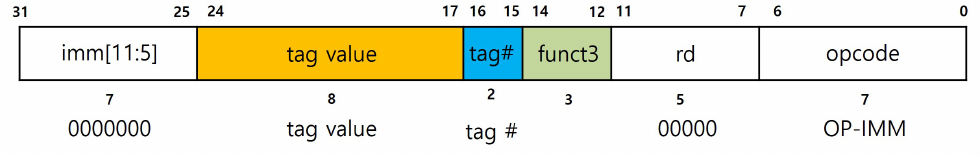
Figure 5. Encoding of Bratter